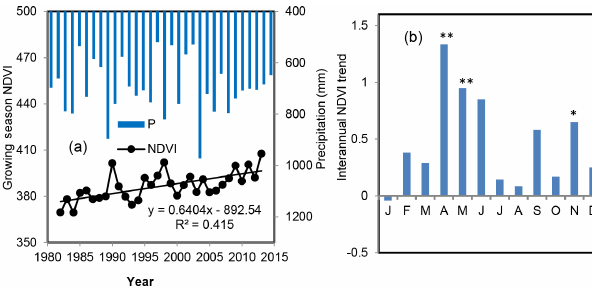
Figure 5. Spatial average trends of the growing season NDVI at annual (a) and monthly (b) scales (significance levels: ∗ is p <0.05; ∗∗ is p <0.01; the NDVI is scaled by